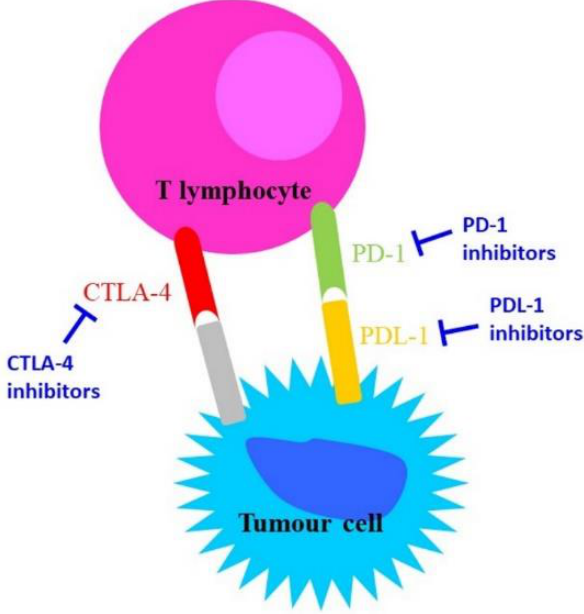
Figure 1. Schematic representation of the mechanisms of action of anti-CTLA-4 and anti-PD-1/PD- L-1.